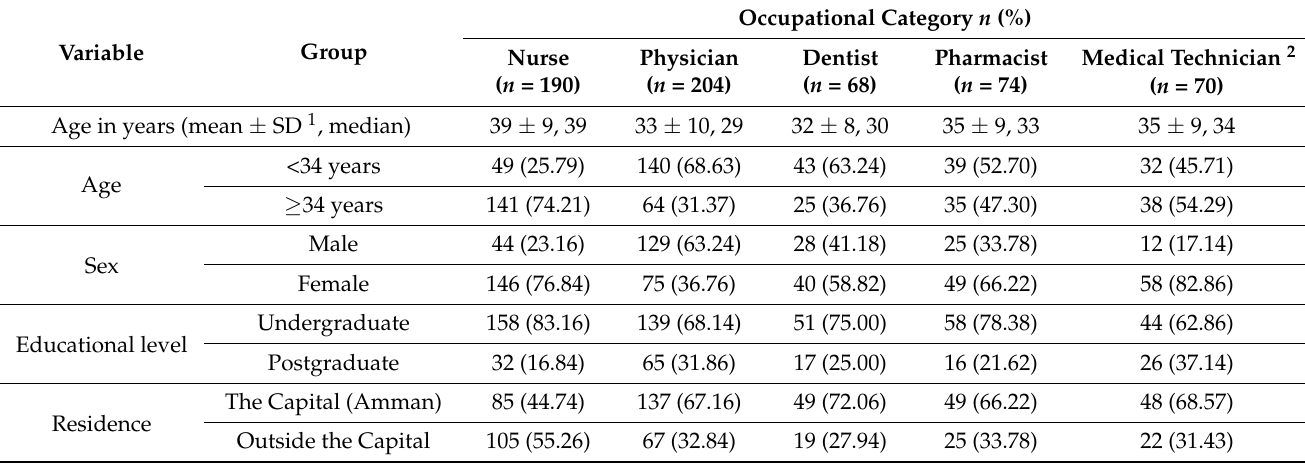
Table 1. The overall features of the study respondents stratified per occupational